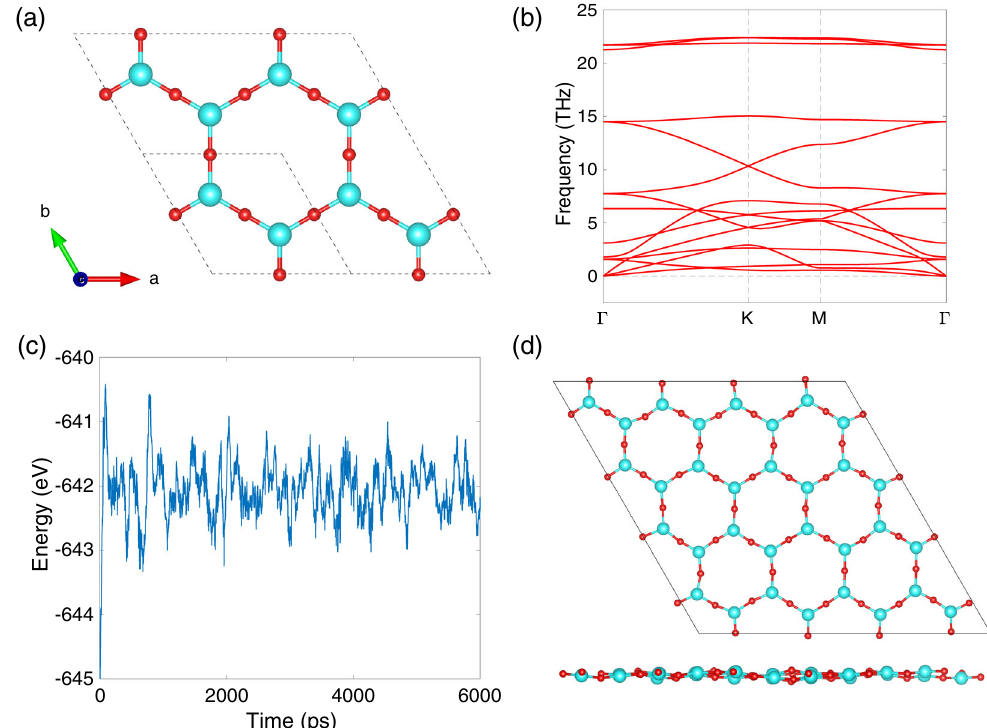
Fig. 1 V 2 O 3 monolayer and its structural stability. a The (2 × 2) supercell of the HK V 2 O 3 monolayer with the unit cell indicated by dashed lines and cyan and red representing the V and O atoms, respectively. b The calculated phonon band dispersion. c The energy fl uctuations during AIMD and d the atomic structure obtained after 6000 ps.